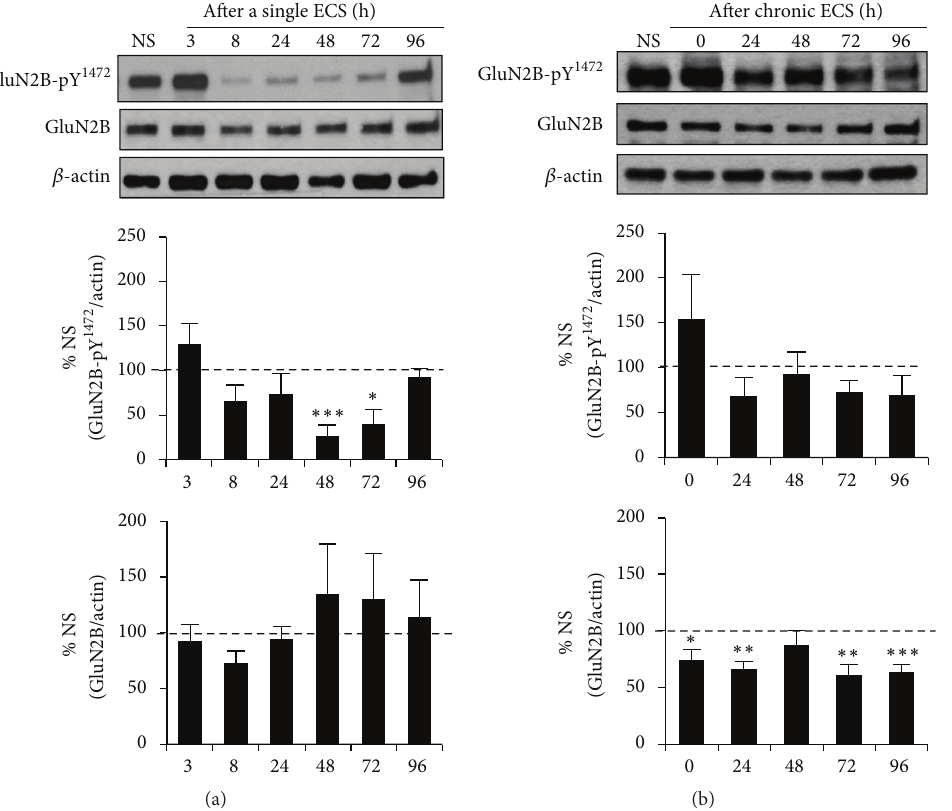
Figure 2: A single ECS but not chronic ECS transiently decreases the level of Tyr 1472 -phosphorylated GluN2B in the hippocampus. Immunoblot analysis for the phosphorylation of GluN2B at Tyr 1472 (Y 1472 ) and total GluN2B expression in the hippocampal crude membrane (P2) fraction following a single ECS ( 𝑛 = 5 rats per time point) (a) and chronic ECS ( 𝑛 = 6 rats per time point) (b). The ratio of the Tyr 1472 - phosphorylated GluN2B band intensity over the 𝛽 -actin band intensity (top graphs) and the ratio of total GluN2B band intensity over the 𝛽 -actin band intensity (bottom graphs) were calculated per each time point and normalized to that of “no seizure” (NS) sham group. Data shown represent the mean band intensity ± SEM. (a) A single ECS transiently decreases the level of Tyr 1472 -phosphorylated GluN2B in the hippocampus at 48h ( ∗∗∗ 𝑝 < 0.005 ) and 72 h ( ∗ 𝑝 < 0.05 ) following a single ECS. (b) Chronic ECS significantly decreases total GluN2B expression over the time course of 96 h in the hippocampus ( ∗ 𝑝 < 0.05 , ∗∗ 𝑝 < 0.01 , and ∗∗∗ 𝑝 < 0.005